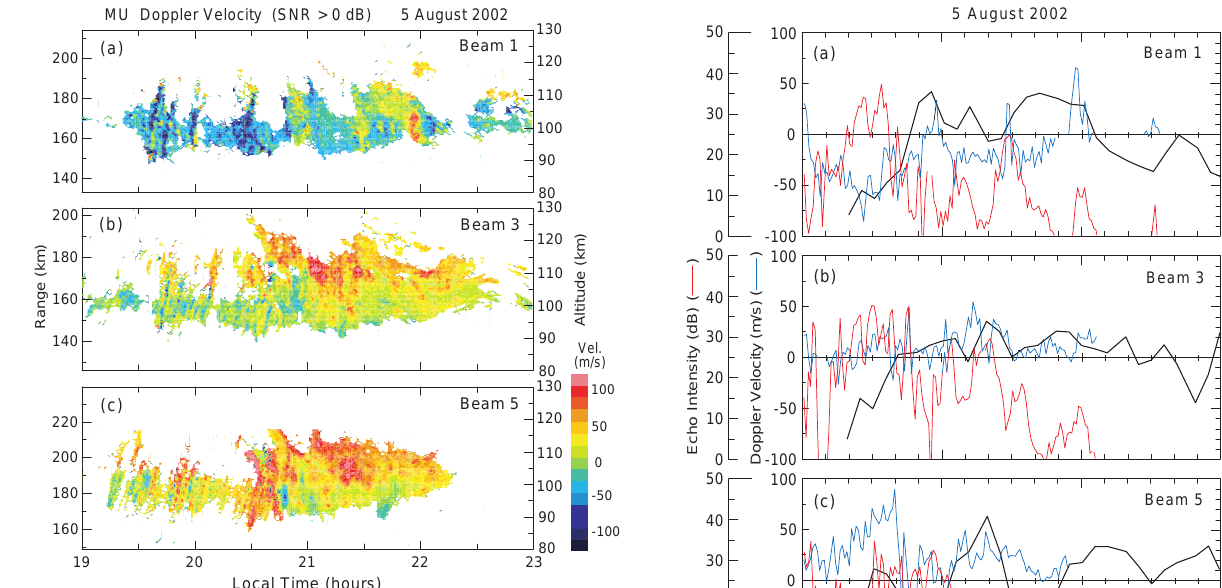
an eastward component, being qualitatively consistent with the motions of the bright 557.7-nm airglow region (Fig. 4a), neutral winds (Fig. 4b), and FAI region (Fig. 5). It is clear that the V d values on beams 3 and 5 after about 21:00 LT increase gradually with altitude: this is also true for beam 4 (not shown). Using the V d data from all the radar beams, we